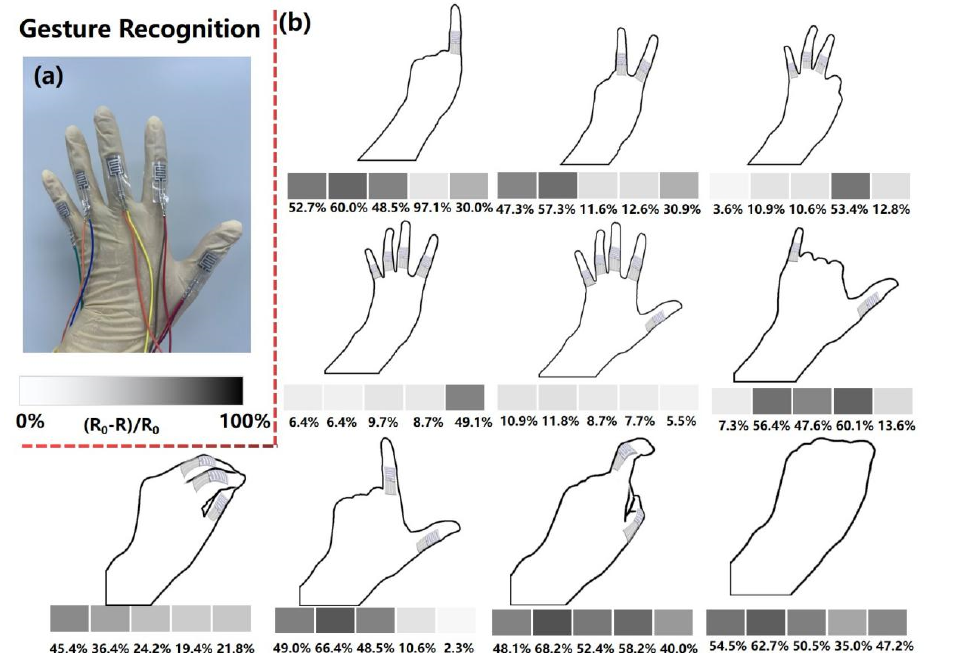
Figure 7. ( a ) The gesture recognition glove based on the fabricated piezoresistive sensor. The prepared five MXene-based piezoresistive sensing devices were assembled at the joints of the glove fingers. ( b ) Gestures of Arabic numerals and their corresponding responsive